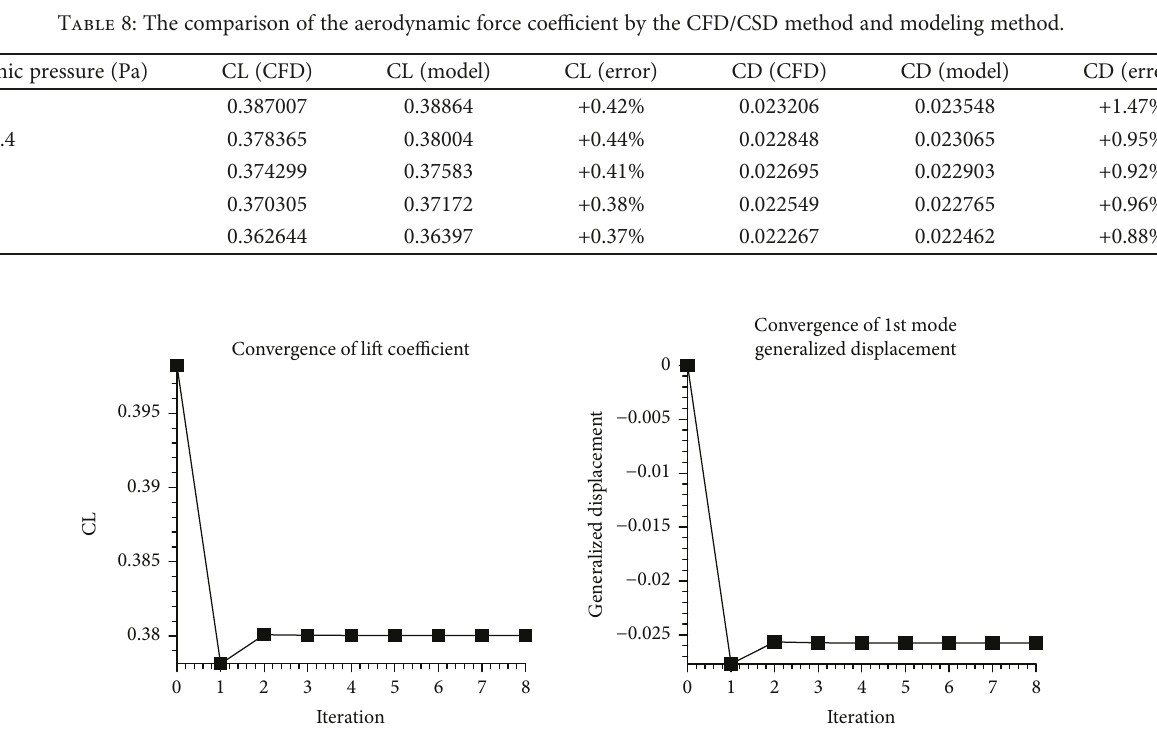
Figure 12: The convergence history of lift coe ffi cient and the 1st mode displacement by the model under Ma = 0 8 , AOA = 1 5 ° , and Q = 40055 4 Pa